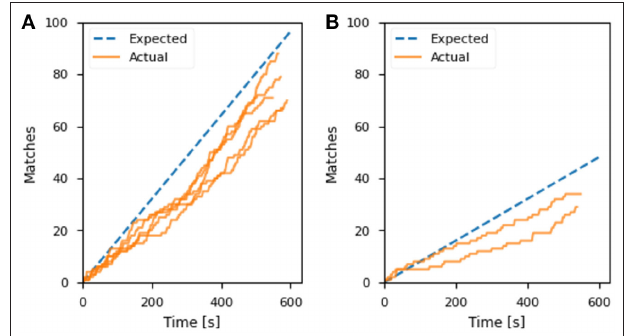
FIGURE 8 | The predicted and actual number of matches over time in the (A) control enhancement of the exoskeleton glove experiment and (B) object identification for autonomous grasping. The time is counted from the first received player match.